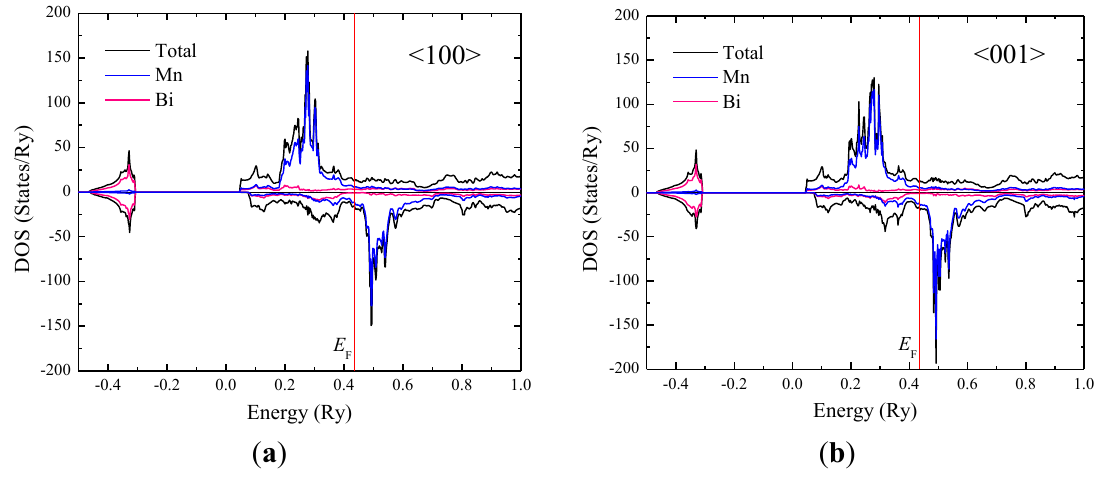
Figure 1. Density of states (DOS) for LTP MnBi in the ( a ) <100> and ( b ) <001> magnetization directions. The black line represents the total DOS, and blue and pink lines represent the partial DOS of Mn and Bi, respectively. The red vertical line corresponds to the Fermi energy ( E F